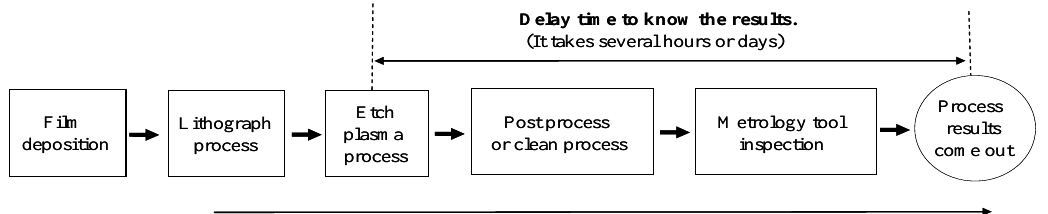
Figure 1. Delay time to know process results in a plasma etch